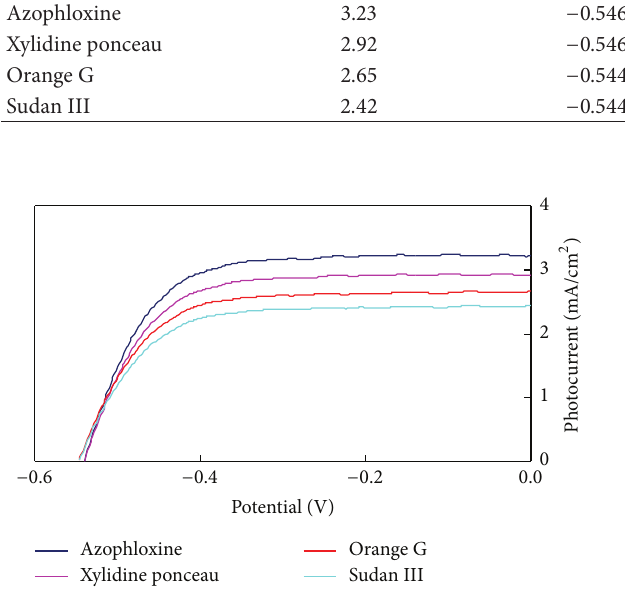
Figure 8: Photocurrent-voltage characteristics of TiO 2 electrodes sensitizedwithazobaseddyesunderilluminationwith100mW/cm 2 light intensity.